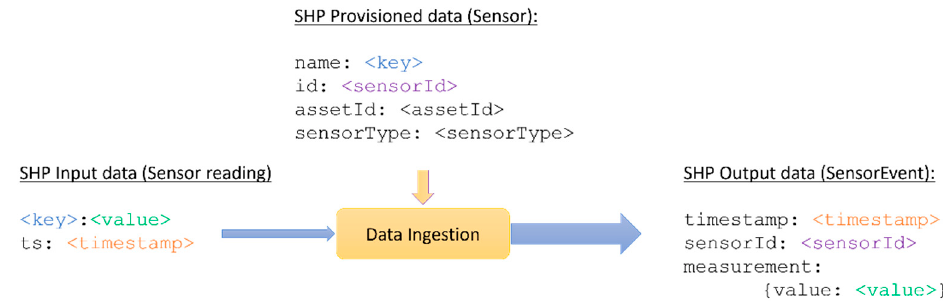
Figure 11. Basic input data model mapping in SHP Data Ingestion.